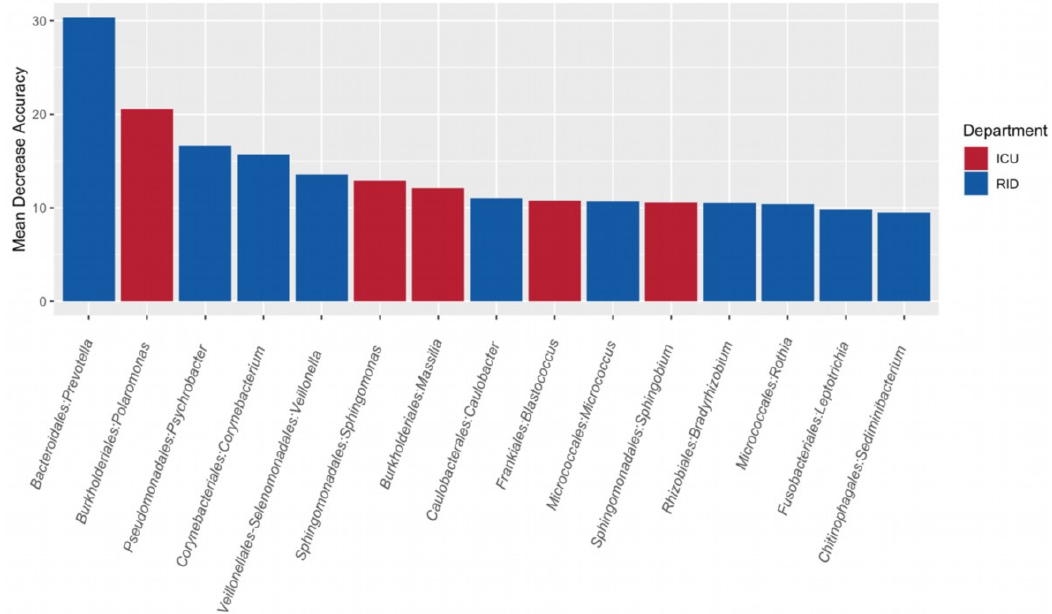
Figure 4. Random forest classification analysis of ICU ( n = 12) and RID ( n = 21) samples, showing taxonomic features with the highest classification variable importance for correctly identifying the department. ICU—Intensive Care Unit; RID—Respiratory Infections Department.